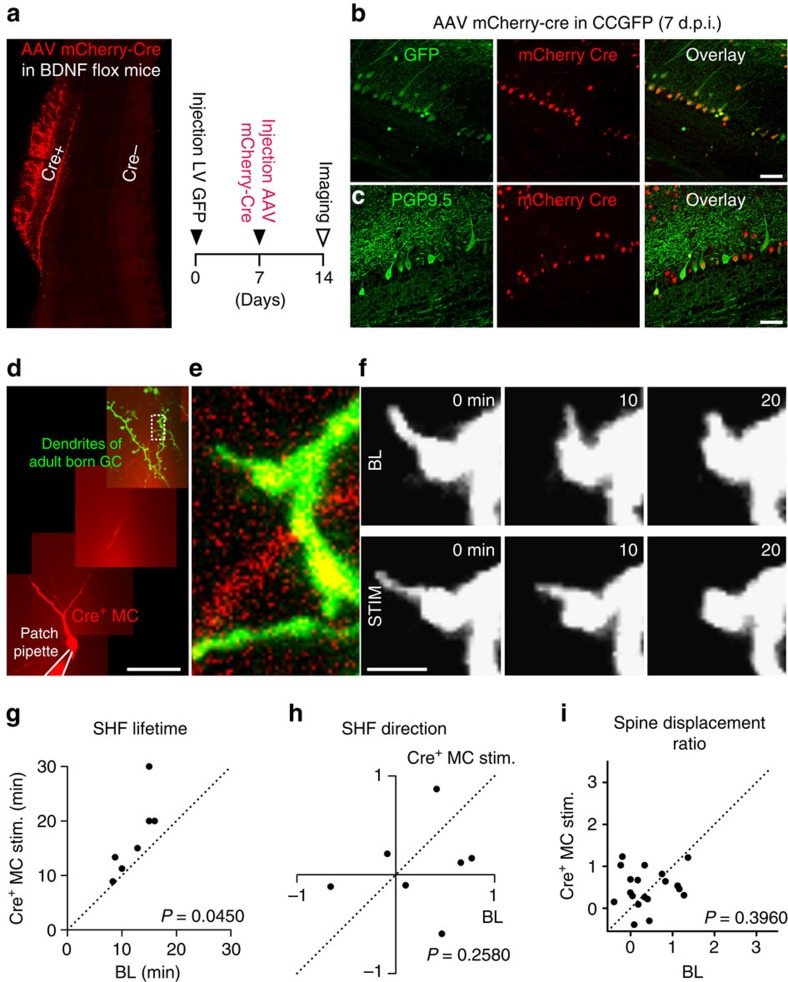
The activity of BDNF-lacking MCs does not induce spine relocation.(a) Illustration of the method used to knock out BDNF from a fraction of MCs in the adult OB. GFP-expressing lentiviral particles were first injected into the RMS to label neuronal precursors. Seven days later, an AAV viral vector expressing Cre-mCherry was injected in the MC layer of the OB of BDNF fl/fl mice. The effect of knocking out BDNF was assessed 7 days later (14 d.p.i. for the adult-born GC). (b) Confocal images of the GFP signal in the MC layer of the GFP reporter line injected with the Cre-mCherry virus. (c) Confocal images of the PGP9.5 protein signal in the MC layer of wild-type mice injected with the Cre-mCherry virus. (d) Reconstruction of the lateral dendrites of an MC infected with the Cre-mCherry viral construct and filled with Alexa594 using a patch pipette. (e) Enlarged view of the boxed area in d. (f) Image sequence of a spine illustrating the effect of an electrical stimulation of a BDNF-deficient MC. (g) Effect of the activity of a Cre-mCherry+ MC on the lifetime of the SHF. These results were obtained from time-lapse images acquired over 30 min of baseline recordings followed by a further 30 min of MC stimulation. (h) Comparison of the direction of an SHF forming in baseline conditions and following the stimulation of a BDNF-deficient Cre-mCherry+ MC. (i) Effect of the stimulation of a BDNF-deficient Cre-mCherry+ MC on spine displacement over 30 min (n=20 spines). (g–i) n=7 cells from six mice. P values were calculated using the paired Student's t-test. Scale bars: 500 μm and 2 μm for a and f, respectively; and 50 μm for b–d.